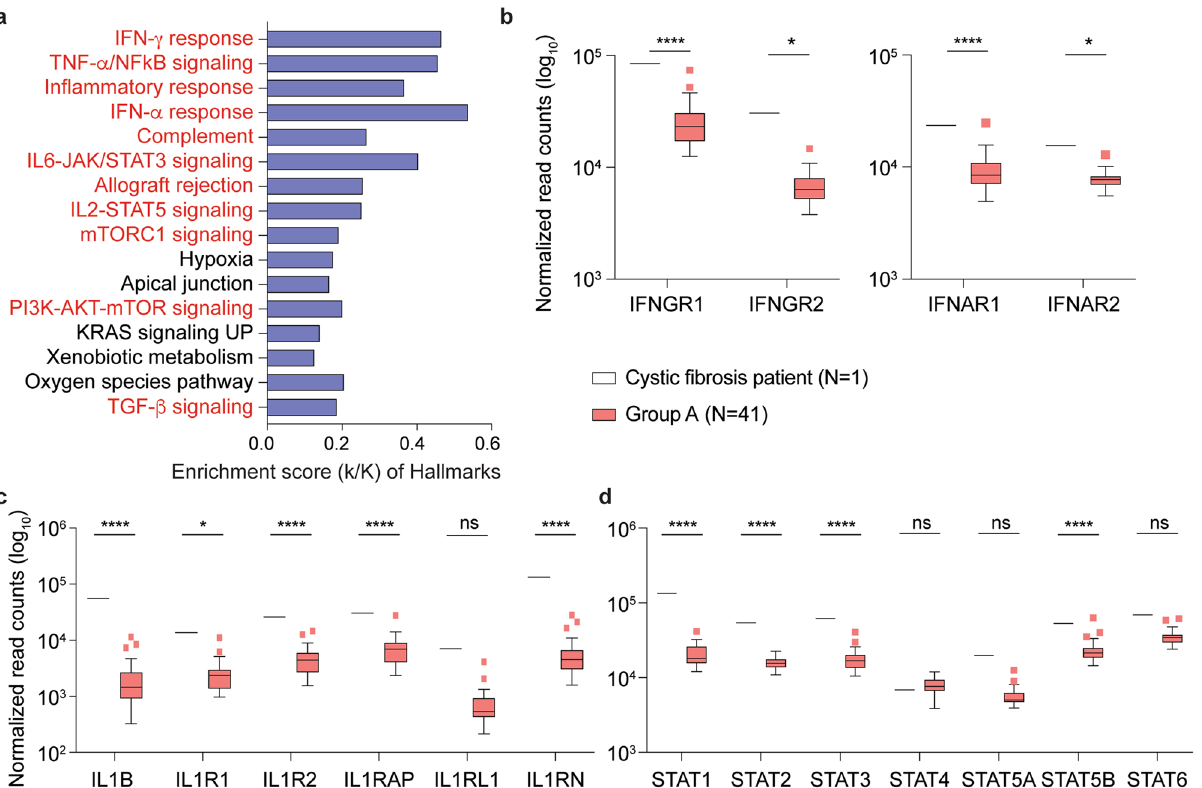
Figure 4. Comparison of gene expression levels between the Cystic Fibrosis patient and the remainder of the asymptomatic seropositive cohort. a Genes expressed at significantly higher levels in the Cystic Fibrosis patient were significantly enriched in Hallmark Gene Sets (FDR q value < 0.005). Out of the top 16, eleven are involved in immune regulation: IFNγ, TNFα via NFκB, inflammatory response, IFNα, complement, IL6-JAK/STAT3, allograft rejection, IL2-STAT5, mTORC1, PI3-AKT-mTOR, TGFβ (labeled in red). The other five gene sets are not directly linked to immune response (labeled in black). b–d Comparison of relative normalized